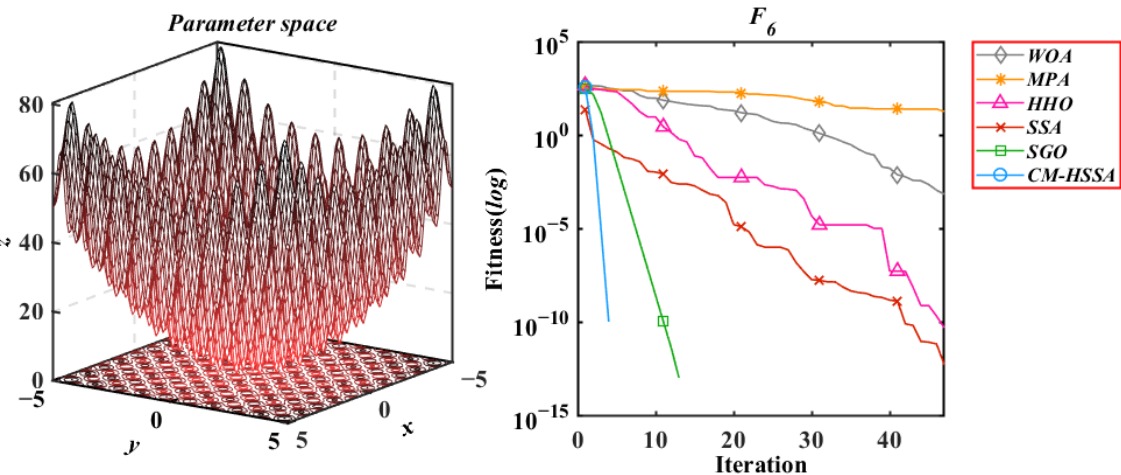
Figure 15. Generalized Rastrigin’s Function.